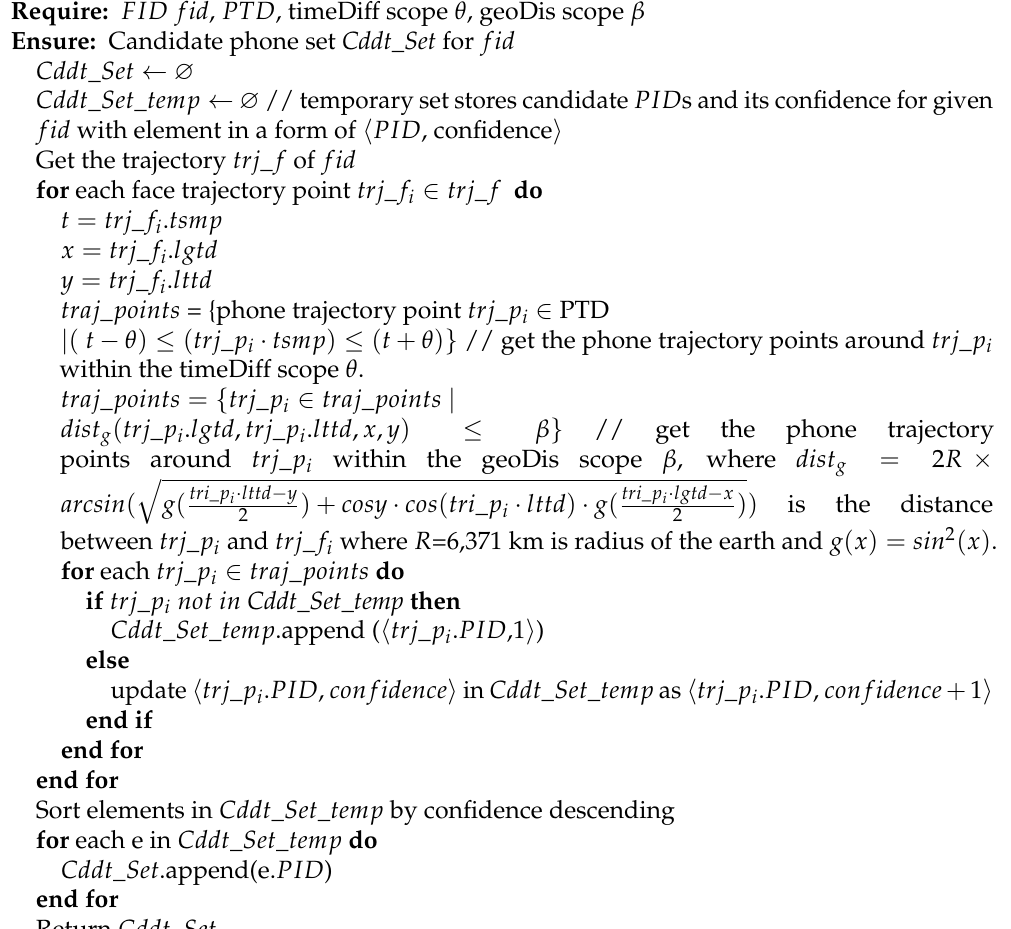
Algorithm 1 Multi-Granularity SpatioTemporal Window Searching